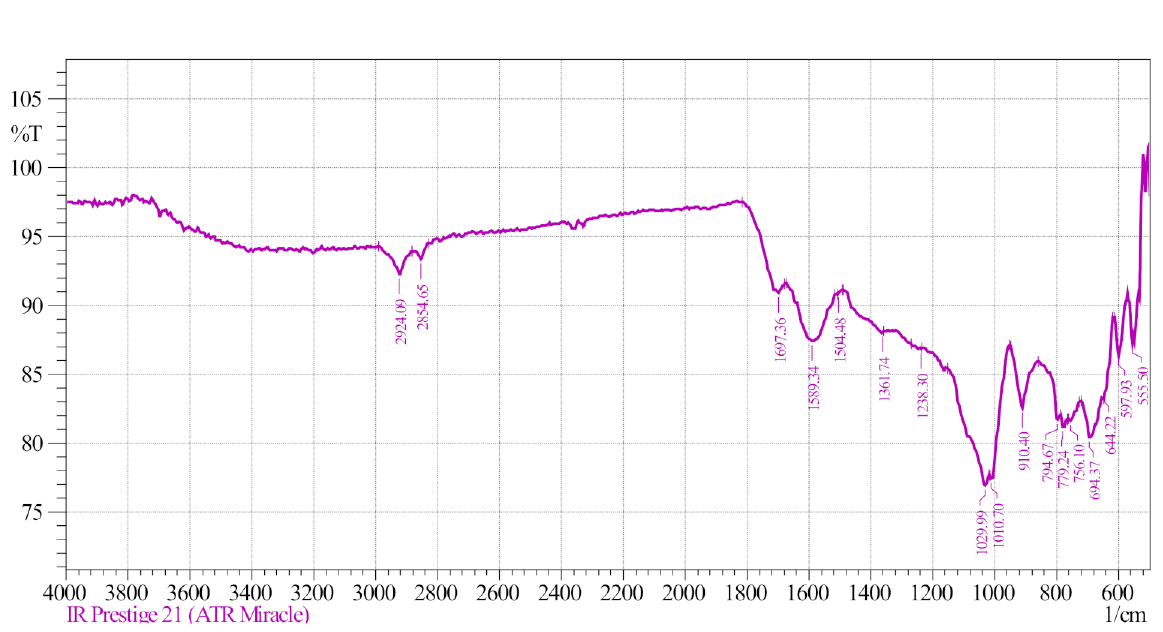
Figure 4. IR spectra of coal mining waste. According to the IR spectrogram, the composition of coal mining waste containedcom- pounds C-H, O-H, occurring at wavelengths 3700–2630 cm − 1 , whereas the wavelengths 1900–1500 cm − 1 werecharacteristic of compounds with a double bond C=C. Diffraction peaks between 1230 and 850 cm − 1 indicated the presence of organosilicon compounds such as Si-O-C, Si-O-Si. Moreover, IR peaks between 870–690 cm − 1 and 650–520 cm − 1 werecharacteristic of sulfo- and aluminate compounds